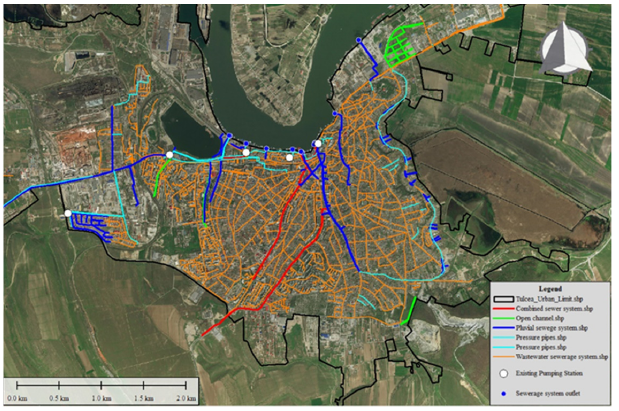
Figure 4. The main collectors of the sewage system (wastewater in orange, pluvial water in blue and green, and combined system in red).